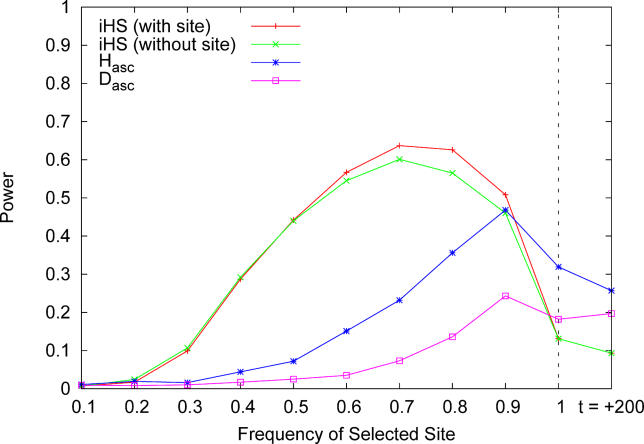
Power to Detect Sweeps-in-Progress at a p-Value of 0.01, Using Various StatisticsSimulation parameters are matched to the Yoruba data, with s = 150. Tests are abased on 51-SNP windows centered on a selected site. The upper curves (iHS) are based on counting the number of SNPs in the window for which |iHS| >2. The green line indicates power when the actual SNP under selection is excluded from the analysis. The lower lines plot power using Fay and Wu's H, and Tajima's D, both calculated using the ascertained genotype data. The line marked t = +200 indicates the power 200 generations after fixation (Ne = 104). Critical values for each statistic at p = 0.01 were obtained using identical simulations with s = 0.